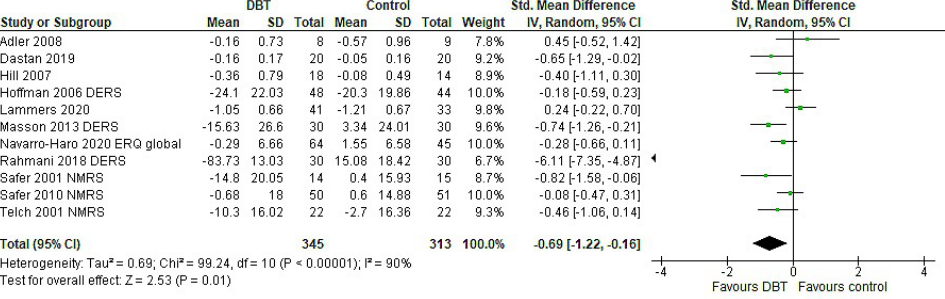
Figure 2. Forest plot: analysis of Emotion Regulation (ER) including one (primary) outcome per